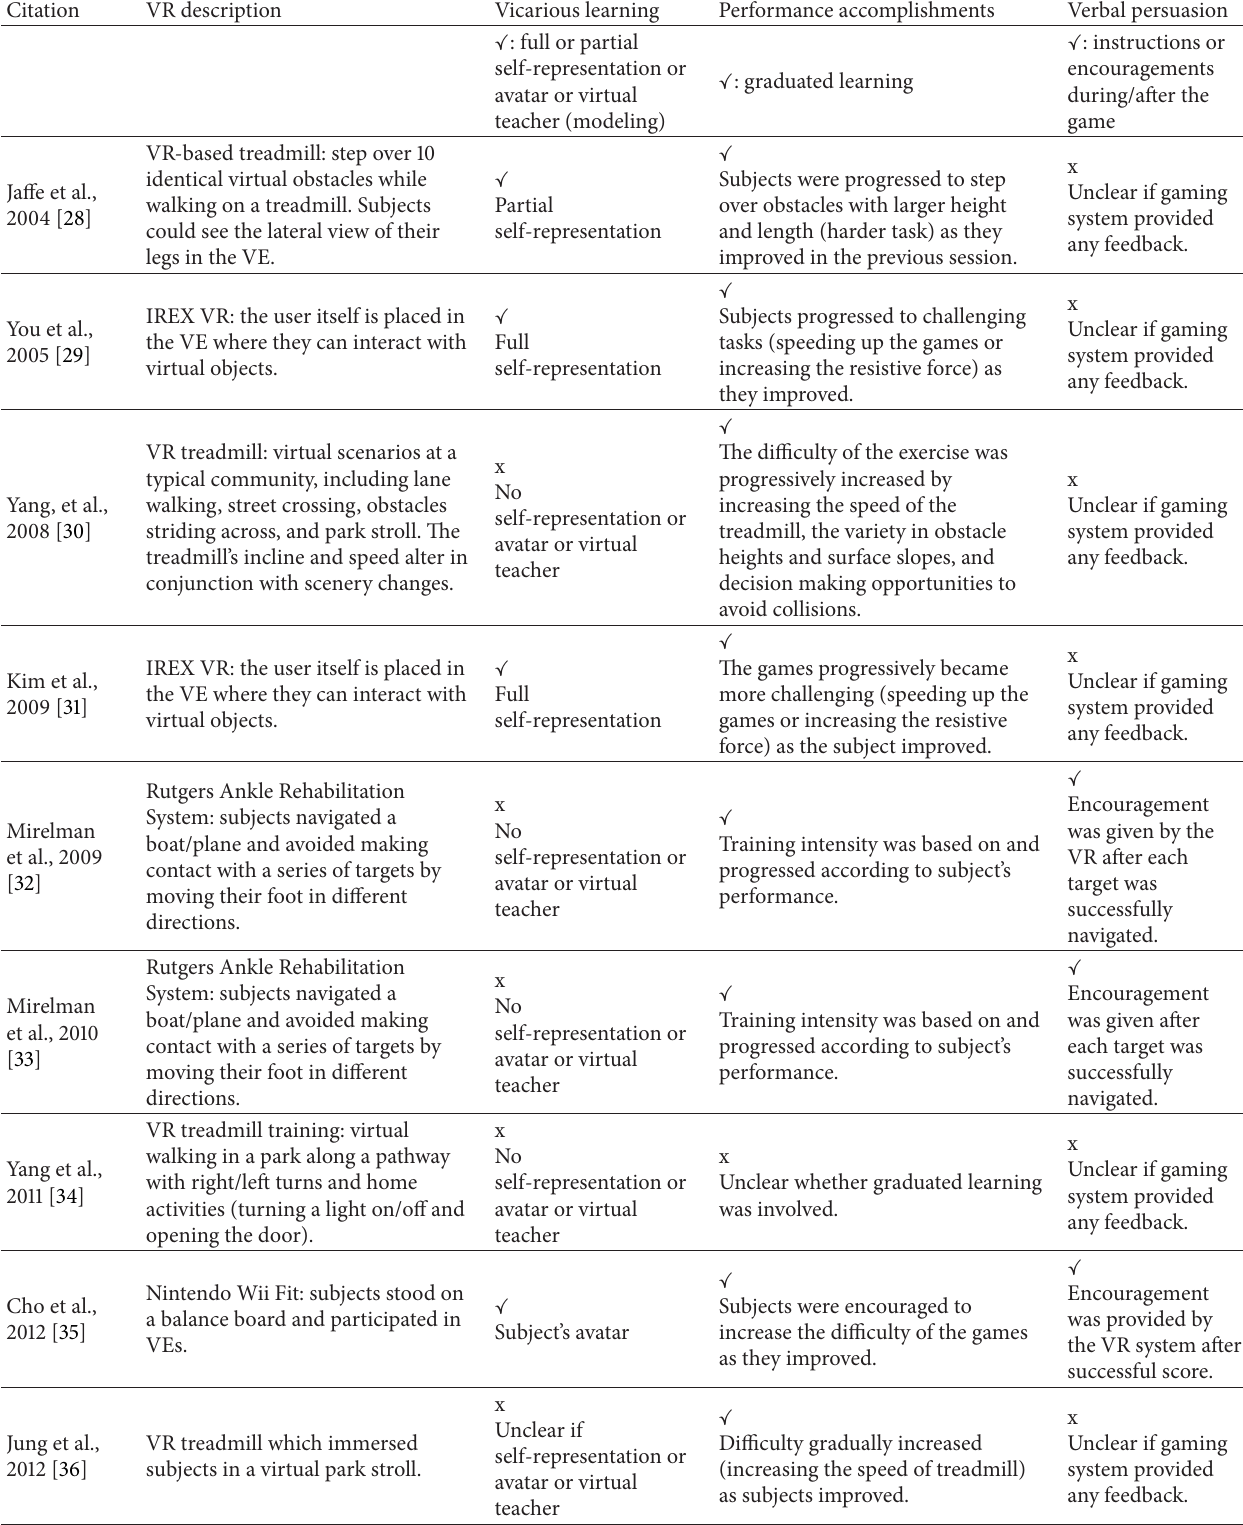
Table 3: Analysis of studies based on Social Cognitive